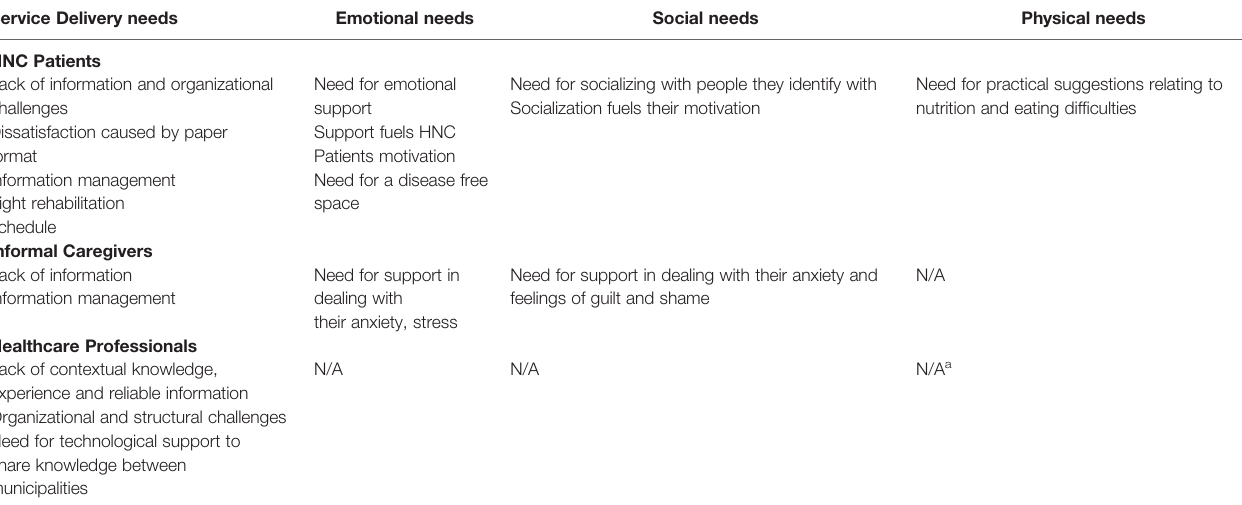
TABLE 2 | Summary of needs - HNC patients, informal caregivers and healthcare